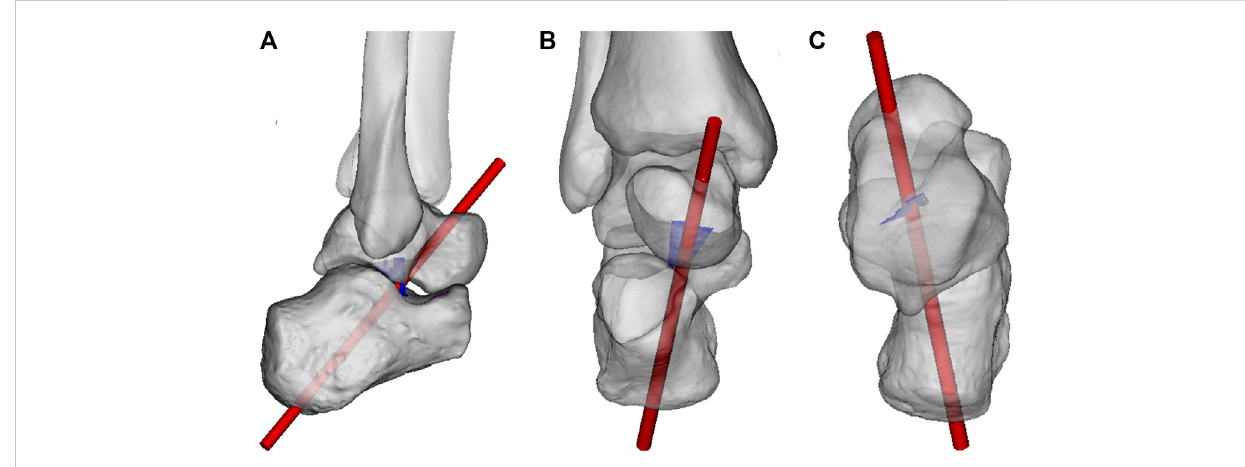
FIGURE 2 Axis of rotation of the subtalar joint. (A) . Lateral view (B) . Anterior view (C) . Superior view. ITCL fi bers indicated in blue.